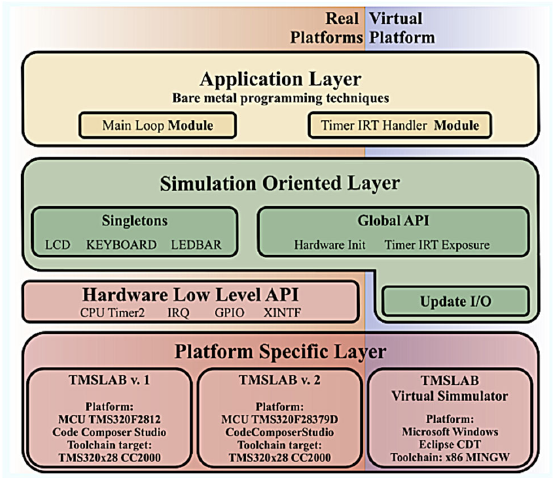
Figure 8. Software ‐ architecture layers for application development using Bare ‐ Metal techniques on TMSLAB module and its virtual simulator. TMSLAB module and its virtual